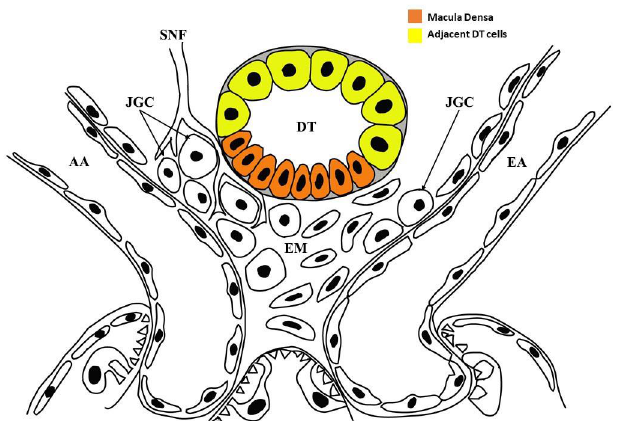
Figure 1. Schematic drawing of the juxtaglomerular apparatus. MD is depicted in orange and DT cells adjacent to MD in yellow. AA, afferent arteriole; DT, distal tubule; EA, efferent arteriole; EM, extraglomerular mesangium; JGC, juxtaglomerular cells; SNF, sympathetic nerve fibers. The figure has been created by Adobe Illustrator software (version 26.4.1; Adobe Inc., San Jose, CA,